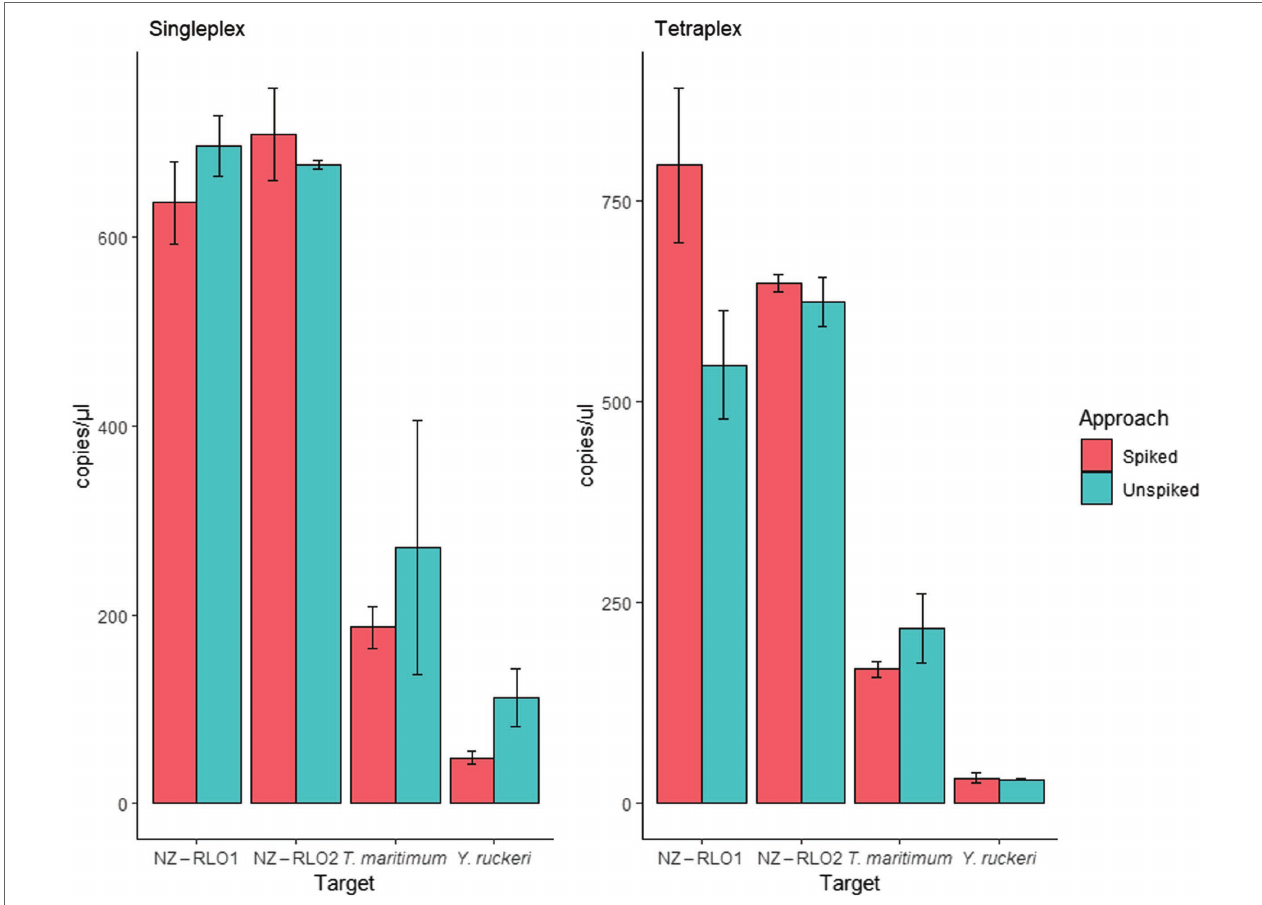
FIGURE 4 | Droplet digital PCR results on singleplex and tetraplex assays run for gBlocks ™ of NZ-RLO1, NZ-RLO2, Tenacibaculum maritimum, and Yersinia ruckeri individually and in combination as well as on unspiked clean (red) and spiked (blue) Oncorhynchus tshawytscha samples. Error bars describe the standard error (SE) of the triplicate